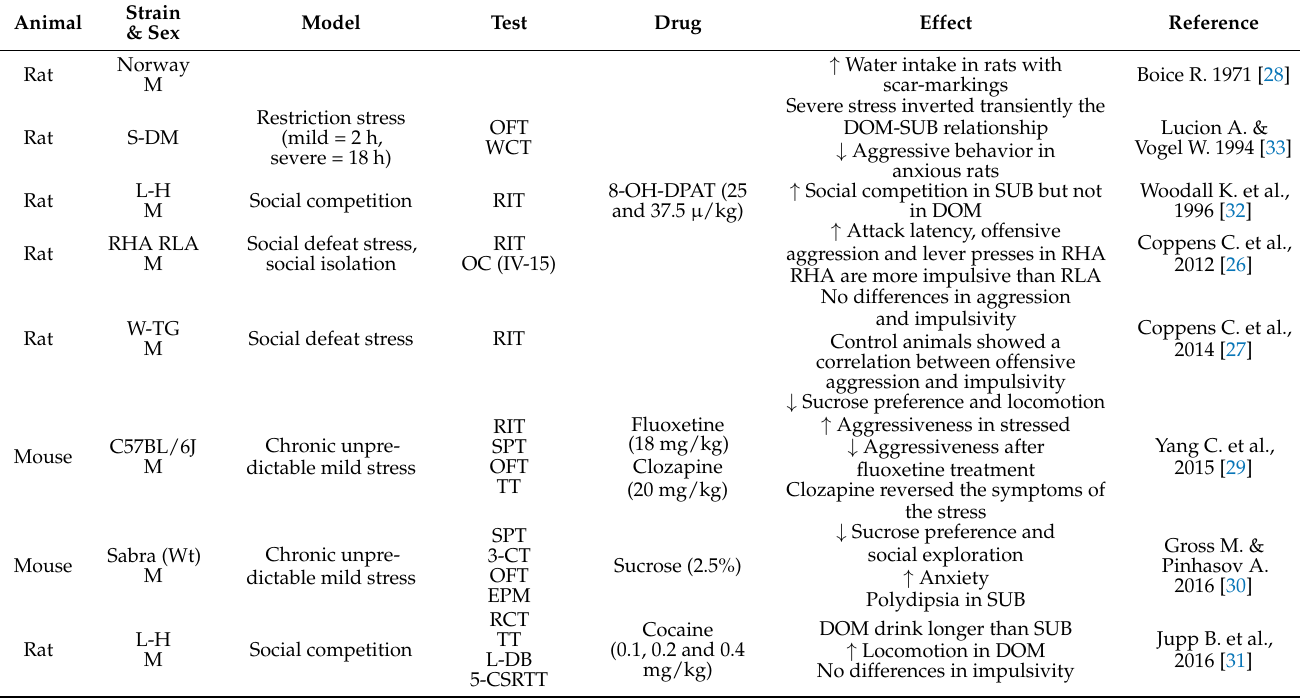
Table 1. Social stress aggressive, competition and impulsive